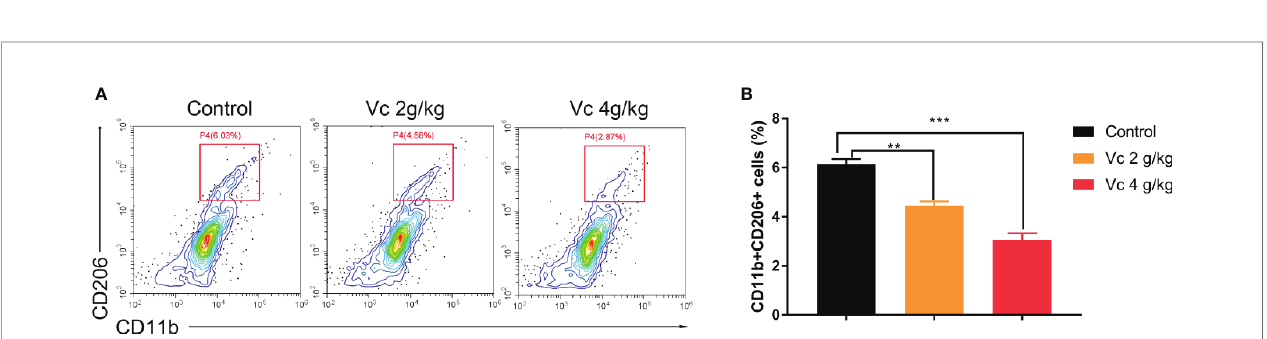
FIGURE 5 | Vitamin C reduces M2 macrophage in ID8 tumor nodules. Flow cytometry analyses of CD11b+CD206+ macrophages from ID8 tumor nodules. (A) Representative examples of CD11b and CD206 pro fi les in ID8 tumor nodules from ID8 tumor-bearing mice and ID8 tumor-bearing mice treated with vitamin C. (B) The quantitation of CD11b and CD206 positive macrophages (CD11b+CD206+) from ID8 tumor nodules. Data are mean ± SEM; n = 3. **p < 0.01, ***p <